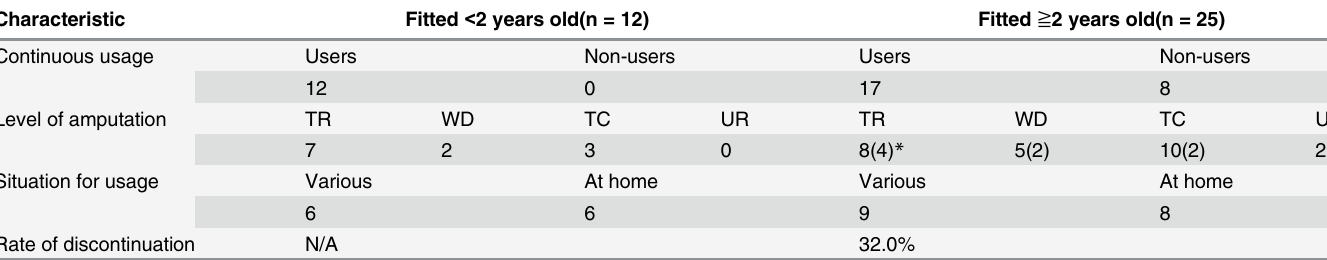
usage, 15 out of the 29 children were using a powered prosthesis not only at home, but also at Table 3. Characteristics of subjects fitted before and after 2 years old, and the situation for usage. Characteristic